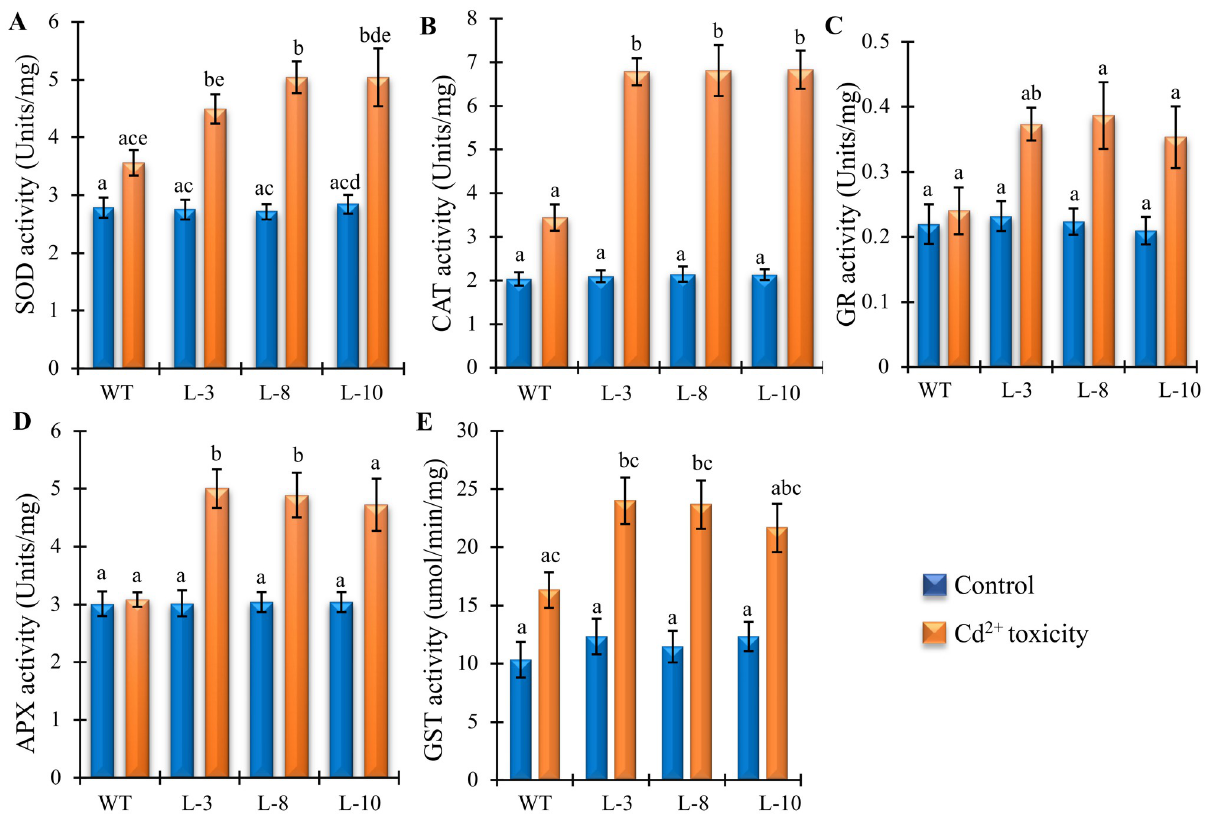
Fig 4. Effects of Cd 2+ stress on the activity of antioxidant enzymes. Activities different antioxidant enzymes including (A) Superoxide dismutase (SOD), (B) Catalase (CAT), (C) Glutathione Reductase (GR), (D) Ascorbate peroxidase (APX) and (E) Glutathione S-transferase (GST) were measured from WT and transgenic plants under control condition and exposed to 100 μ M CdCl 2 . Data represent as mean value ± standard deviation of three biological replicates (n = 3). Different letters above the bar showed significant difference between the treatments and plant genotypes (P < 0.05, ANOVA; post hoc